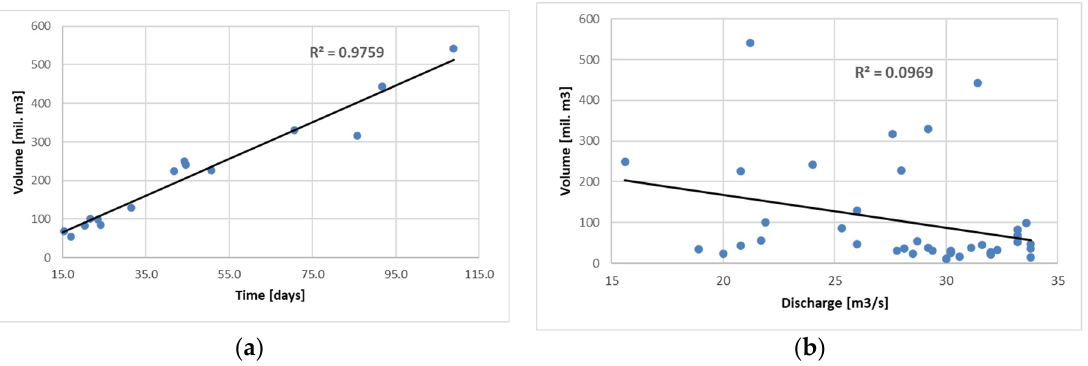
Figure 4. Correlations: ( a ) drought duration ‐ deficit volume and ( b ) minimum discharge ‐ deficit volume.